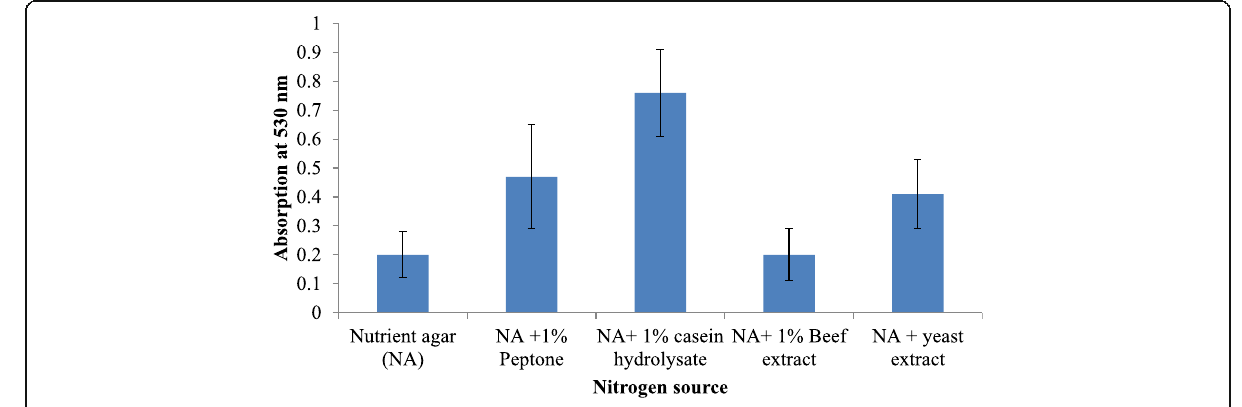
Fig. 5 Effect of nitrogen source on prodigiosin